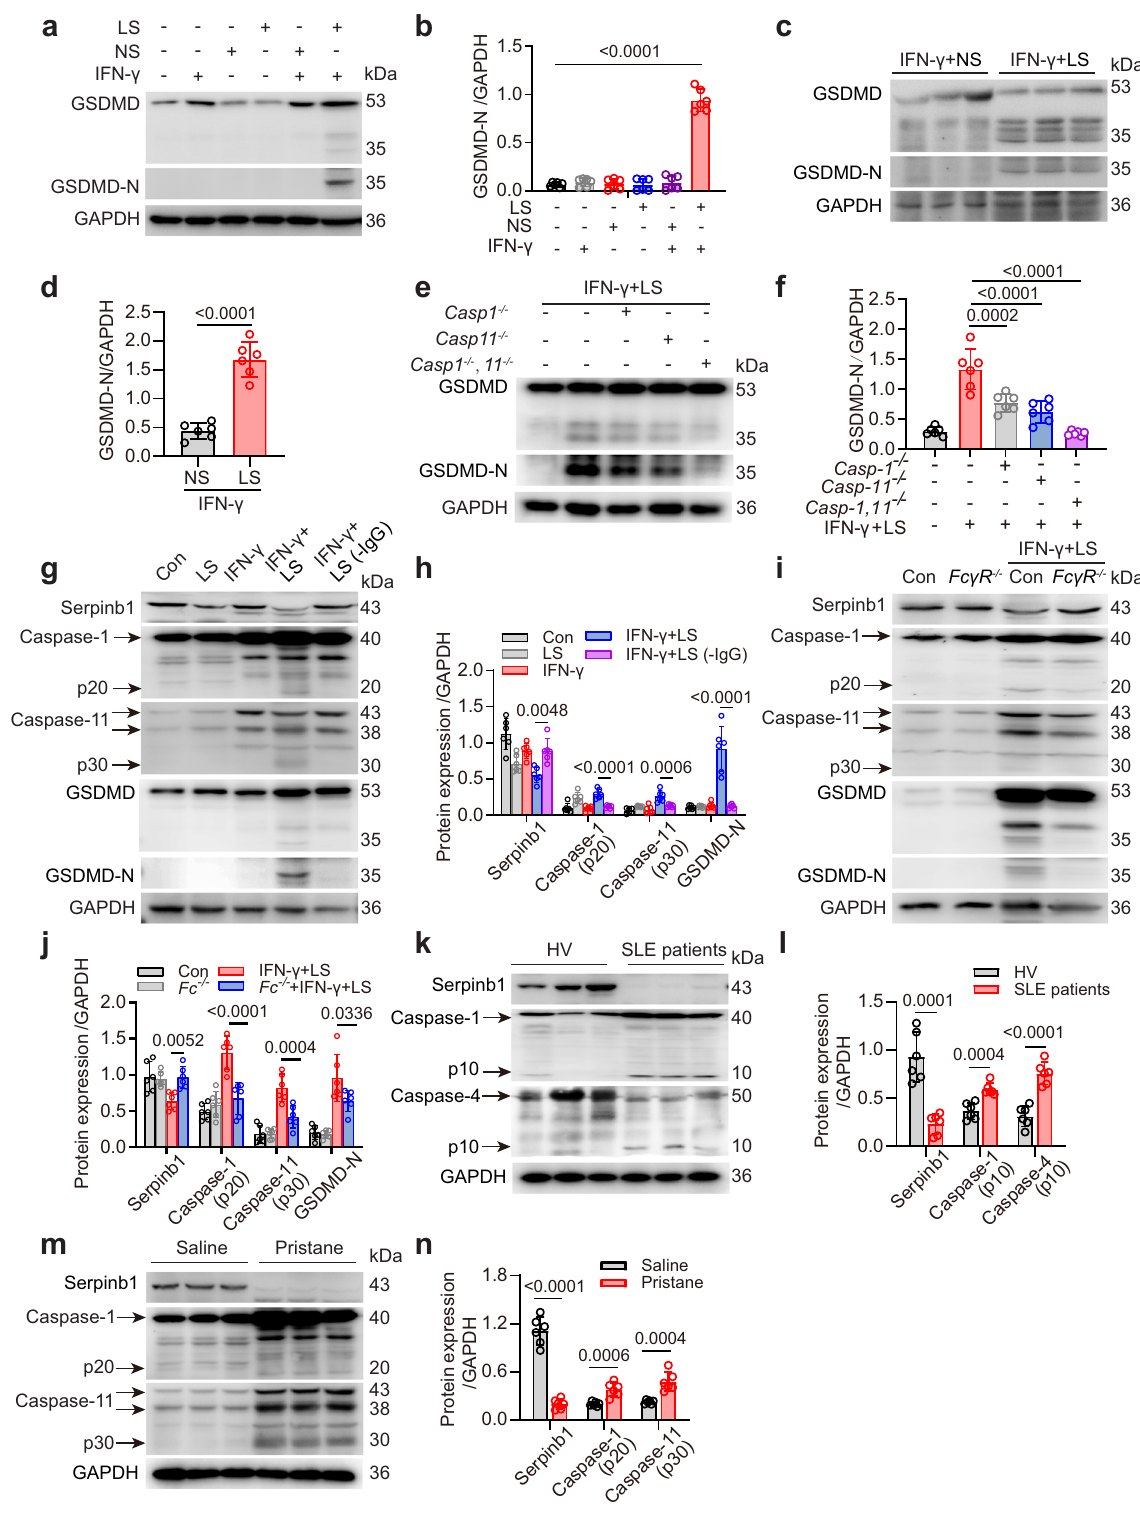
weight in MRL / lpr mice were signi fi cantly suppressed after DSF treat- ment(Fig.9a – d).Reducedlevelsofanti-dsDNA,anti-RNPs,andanti-Sm (Fig. 9e – g) autoantibodies in MRL/lpr mice following DSF treatment were observed. Serum levels of IL-1 β , IL-18 and mtDNA were also reduced in the MRL/lpr mice after DSF treatment (Fig. 9h – j). Kidney histopathologicalanalyses revealed severe glomerular,interstitial, and vascular lesions in the vehicle-treated MRL / lpr mice consistent with